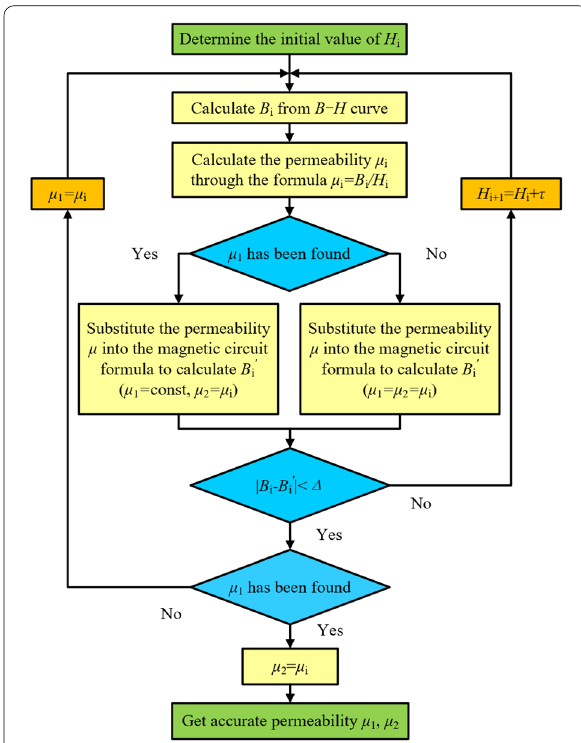
Figure 12 Iterative